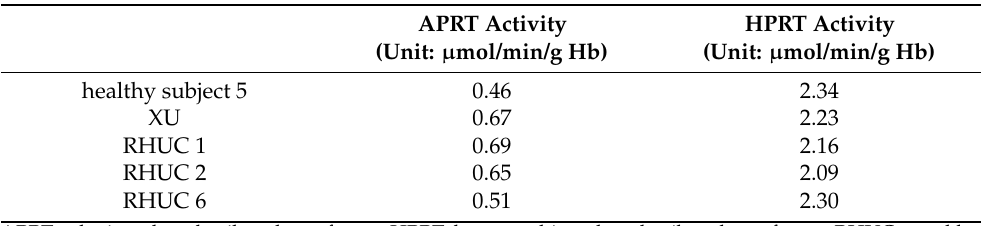
Table 2. Comparison of purine salvage enzyme activity in RBC. APRT and HPRT activities of